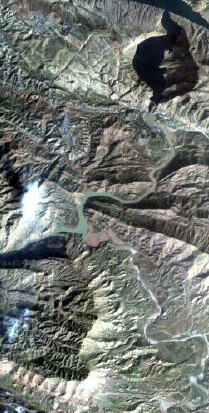
Figure 1. Hyperion image of region of